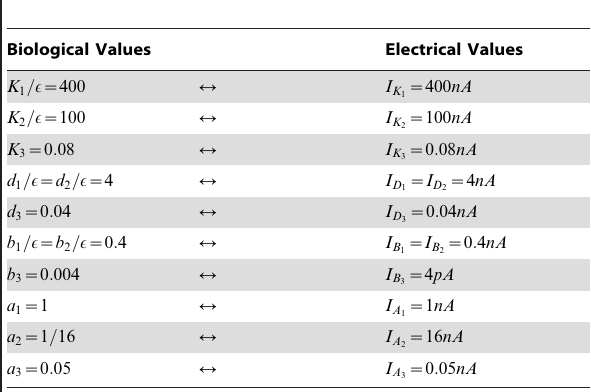
Biological Values